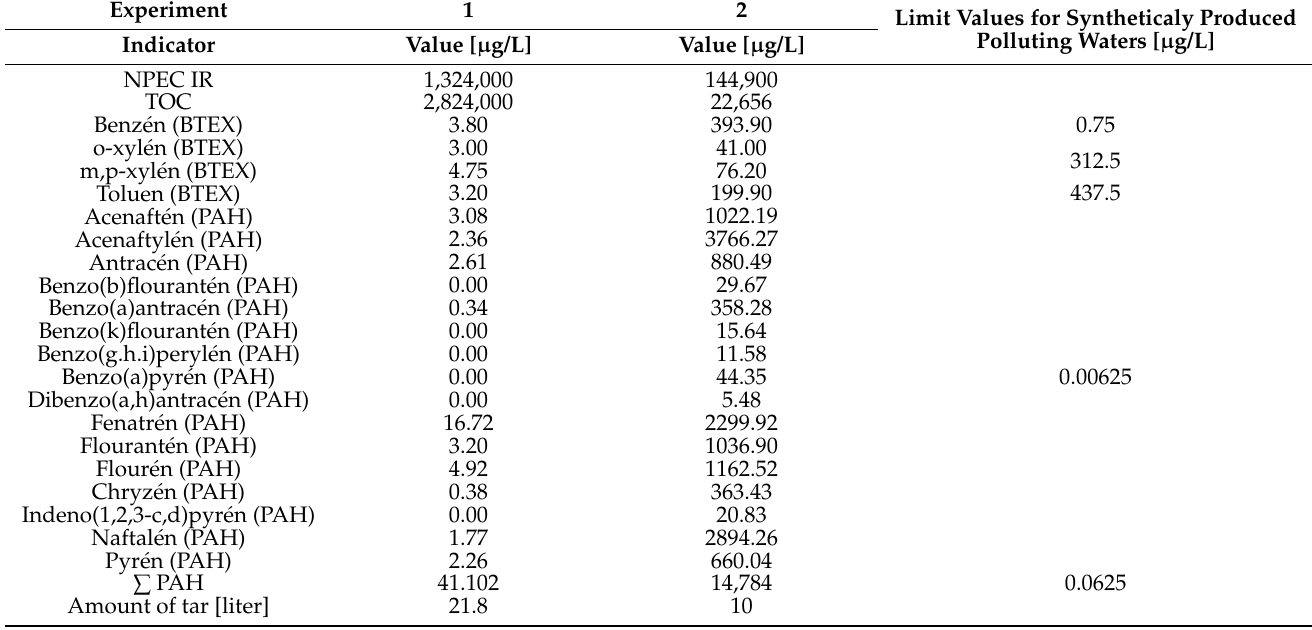
Table 2. Values of pollutants in tar samples (NPEC IR, TOC, BTEX, PAH) [28,37] and authors.